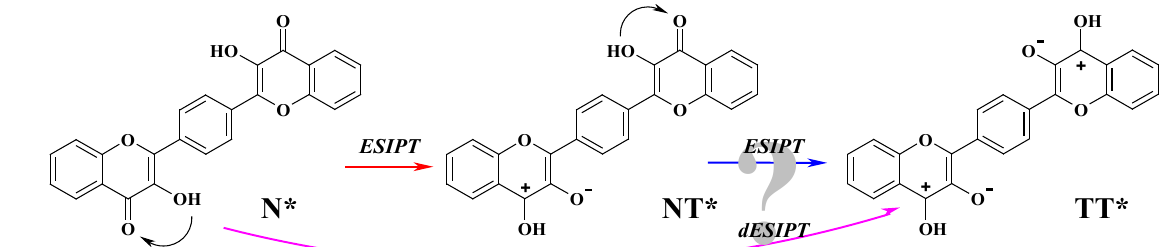
Figure 2. Considering the excited state double proton transfer in diflavonol